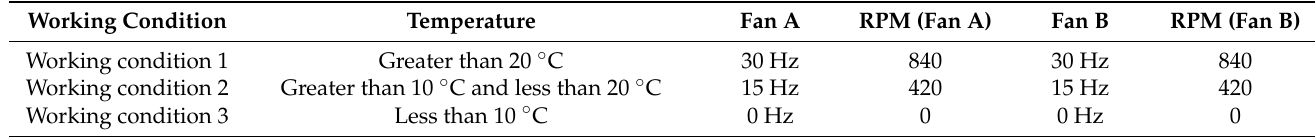
Table 1. Frequency modulation scheme of Fan A and Fan